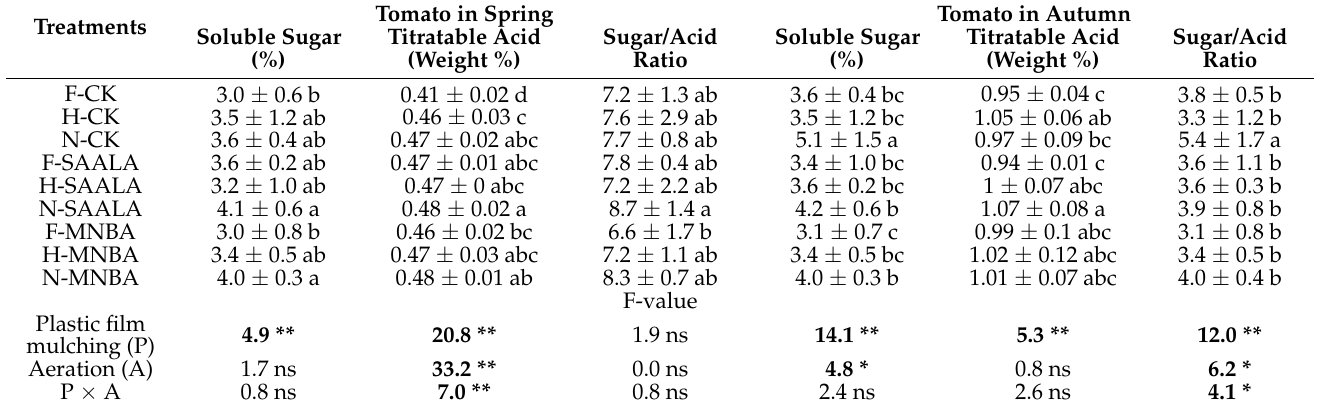
Table 4. Effects of different aeration treatments on flavour indices of tomato.